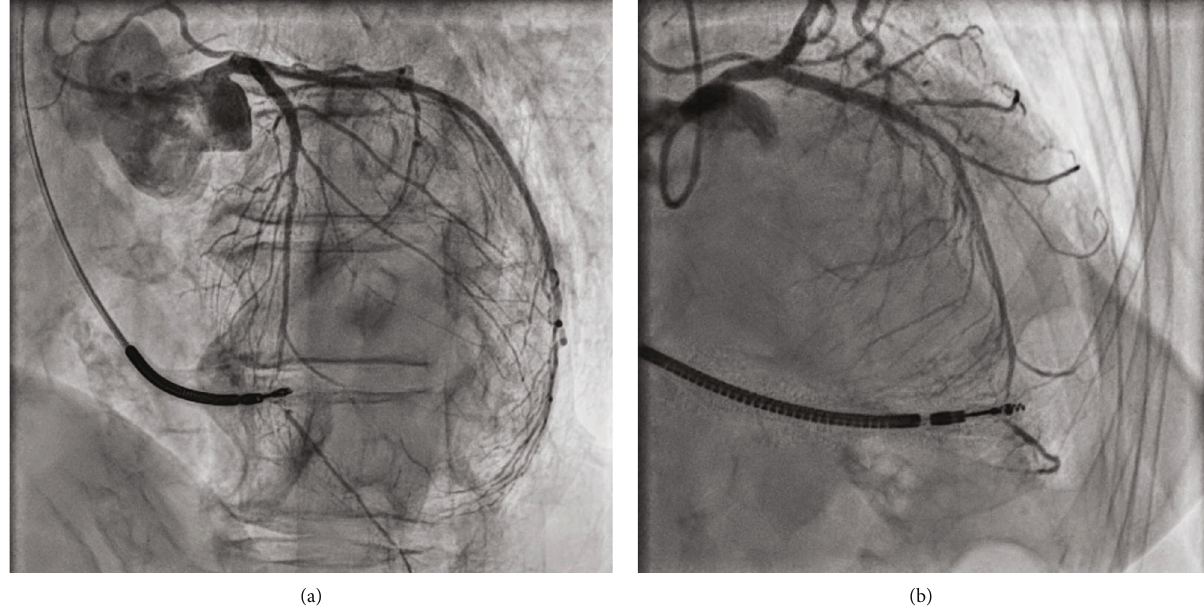
Figure 3: Coronary angiography in the 30 ° left anterior oblique (a) and 20 ° right anterior oblique (b) views, showing compression of the LAD. Of note, in the right anterior oblique view, the implantation site is distal to the heart silhouette, suggesting a very anterior position.